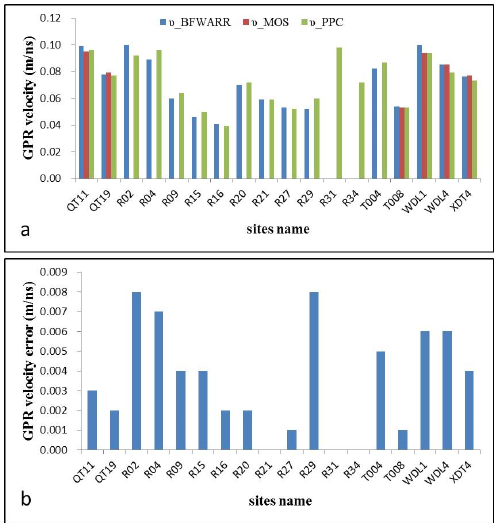
Figure 4. ( a ) Velocity comparison acquired by three different GPR detecting methods, blue bar ( υ _BFWARR); velocity from wide-angle reflection and refraction methods, red bar ( υ _MOS); velocity from multi-o ff set soundings, green bar ( υ _PPC); velocity from pit profile calibration. ( b ) Absolute error between υ _PPC, υ _BFWARR, and υ